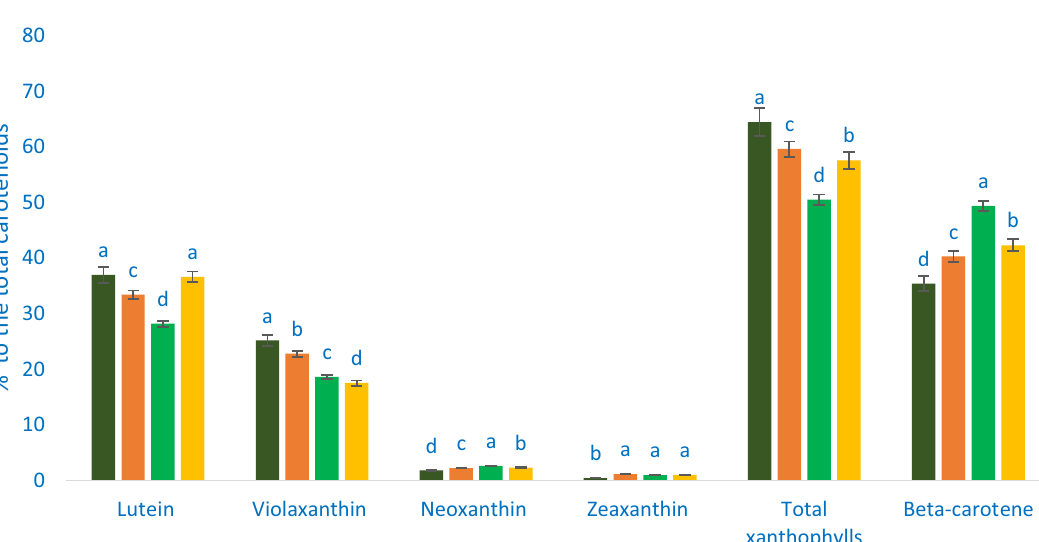
Figure 4. Percentage of zeaxanthin, lutein, violaxanthin, neoxanthin, total xanthophyll, and β-carotene to the total carotenoids in four selected A. gangeticus leafy vegetables, different letters in the bar are differed significantly by Duncan Multiple Range Test ((P < 0.01), (n =